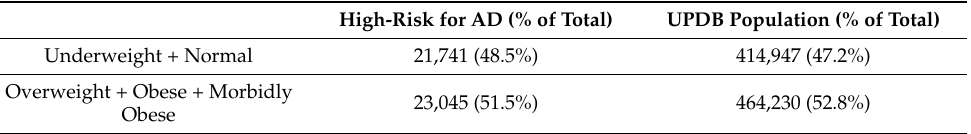
Table 4. Body mass index distributions for 44,786 high-risk non-AD subjects at high-risk for AD and 879,177 individuals in UPDB with linked Drivers’ License data and extensive genealogy data ( p = 2.625 × 10 − 8